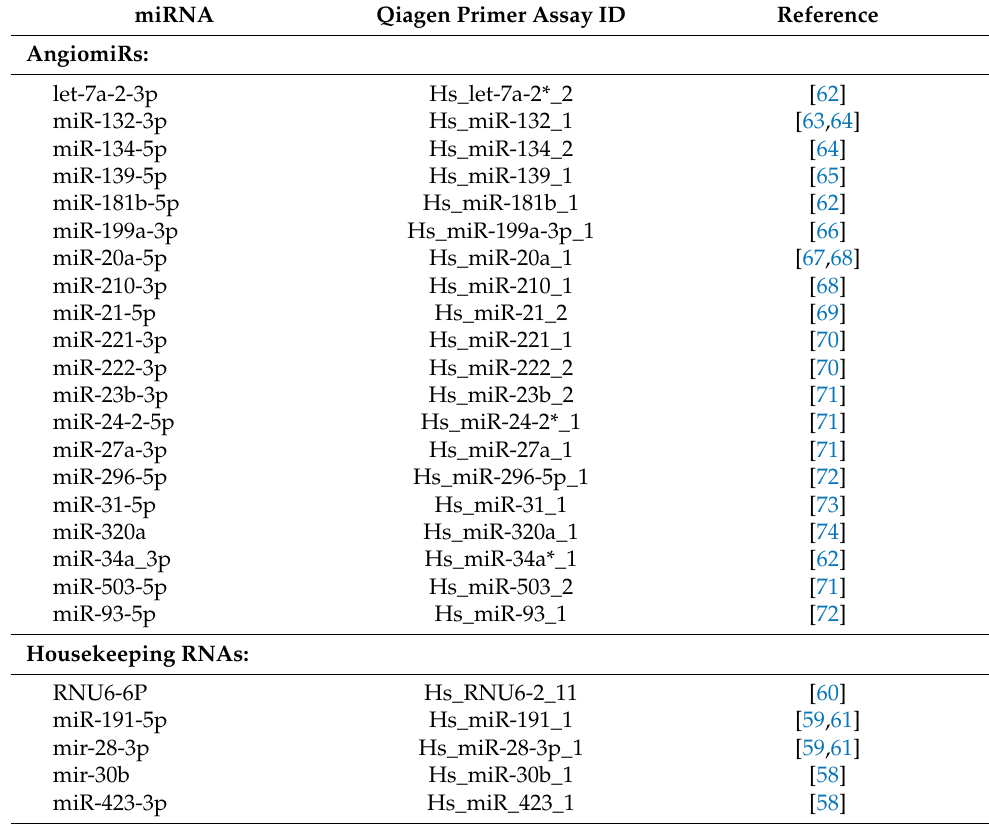
Table 3. Primers for angiomiRs and housekeeping